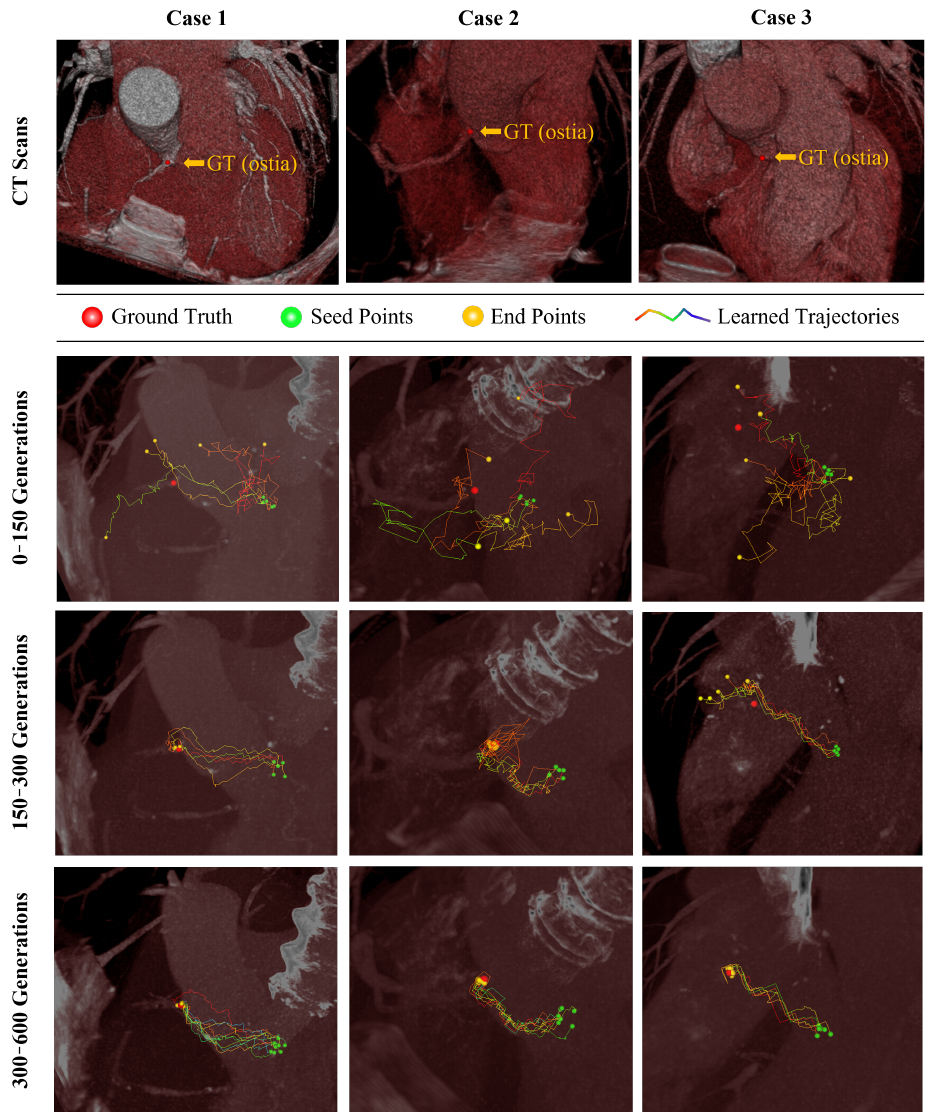
Figure 6. Visualization of training agents for coronary ostia. Robust convergence over a generation is observed for coronary ostia detection problems. GT, ground